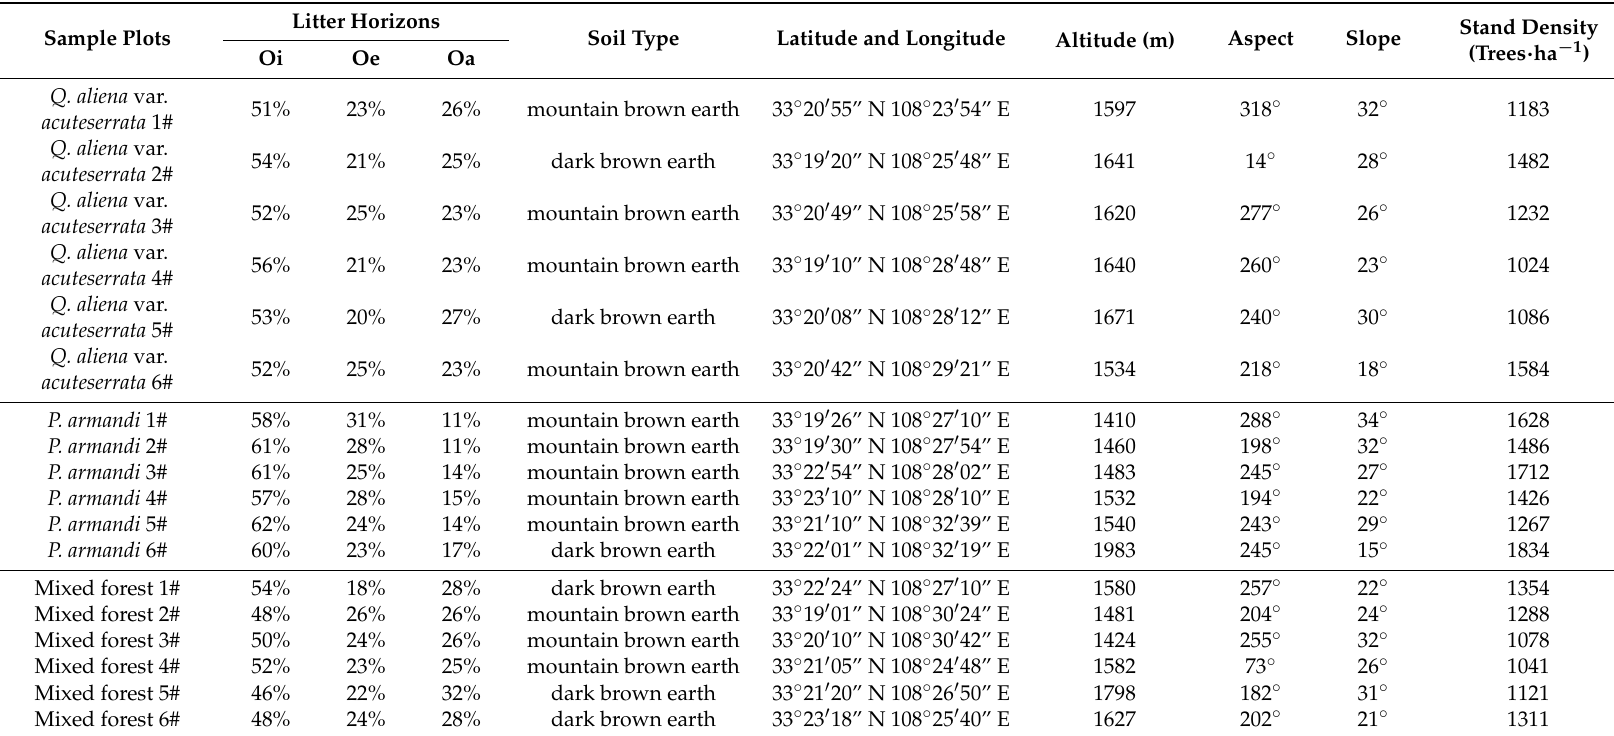
Table 1. Plot characteristics in the main types of forests in the Huoditang Experimental Forest Farm in the Qinling Mountains (China). Litter Horizons Sample Plots